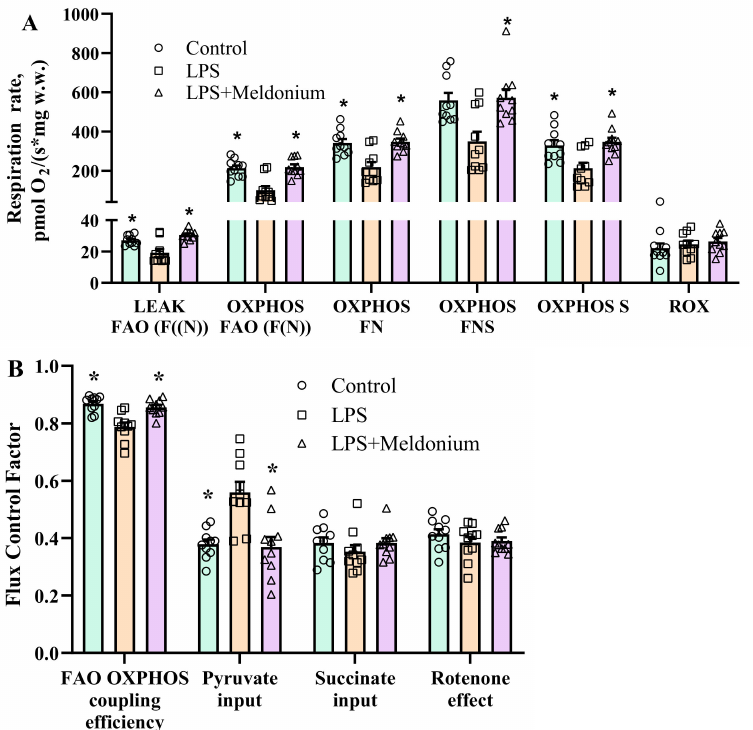
Figure 5. Mitochondrial respiration rate ( A ) and flux control factors ( B ) in cardiac fibers of the left ventricle after administration of meldonium at a dose of 100 mg/kg for 3 weeks in a model of lipopolysaccharide (LPS)-induced left ventricle dysfunction. LPS induced the inhibition of fatty acid (FA)-dependent oxidative phosphorylation ( A , B ) and subsequently increased pyruvate metabolism ( B ). Treatment with meldonium fully restored mitochondrial bioenergetics ( A , B ) to the level of the normal control group. The results are presented as the mean ± SEM of 9 animals. * p < 0.05 vs. the LPS group, one-way ANOVA with Dunnett’s multiple comparison test. Flux control factor, the contribution of each substrate/pathway to the respiration rate; p , pyruvate; S, succinate; F, FA oxidation-dependent pathway; N, NADH pathway; LEAK, substrate-dependent state; OXPHOS, oxidative phosphorylation-dependent state; ROX, residual oxygen